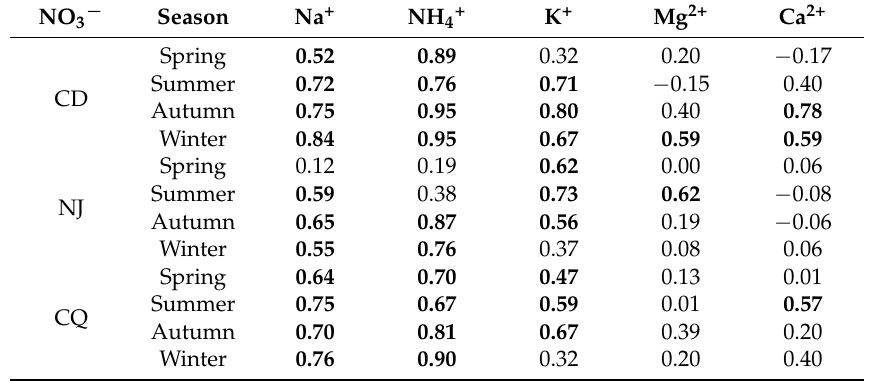
Table 2. The correlation coefficients ( R ) between NO 3 − and cations in PM 2.5 of CD, NJ, and CQ. NO 3 − Season Na + NH 4+ K + Mg 2+ Ca 2+ Spring CD